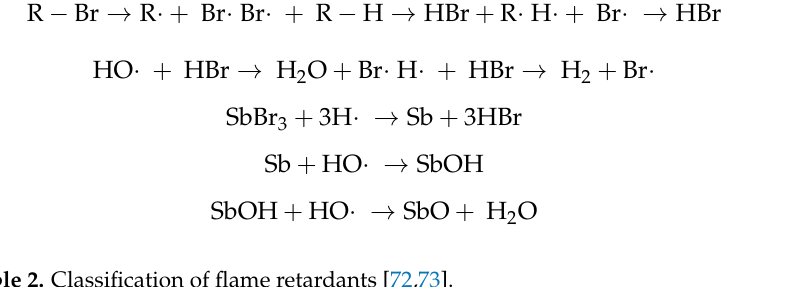
Table 2. Classification of flame retardants [72,73]. Classification by Usage Classification by